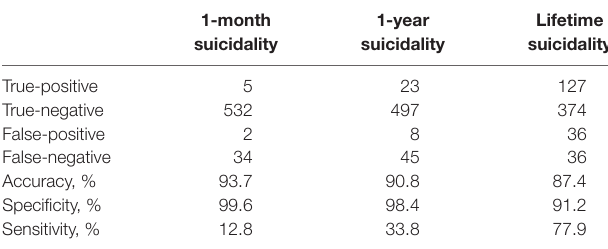
TaBle 2 | Confusion matrix and classification scores in each predictive model. TaBle 1 | Sociodemographic characteristics of participants, with average